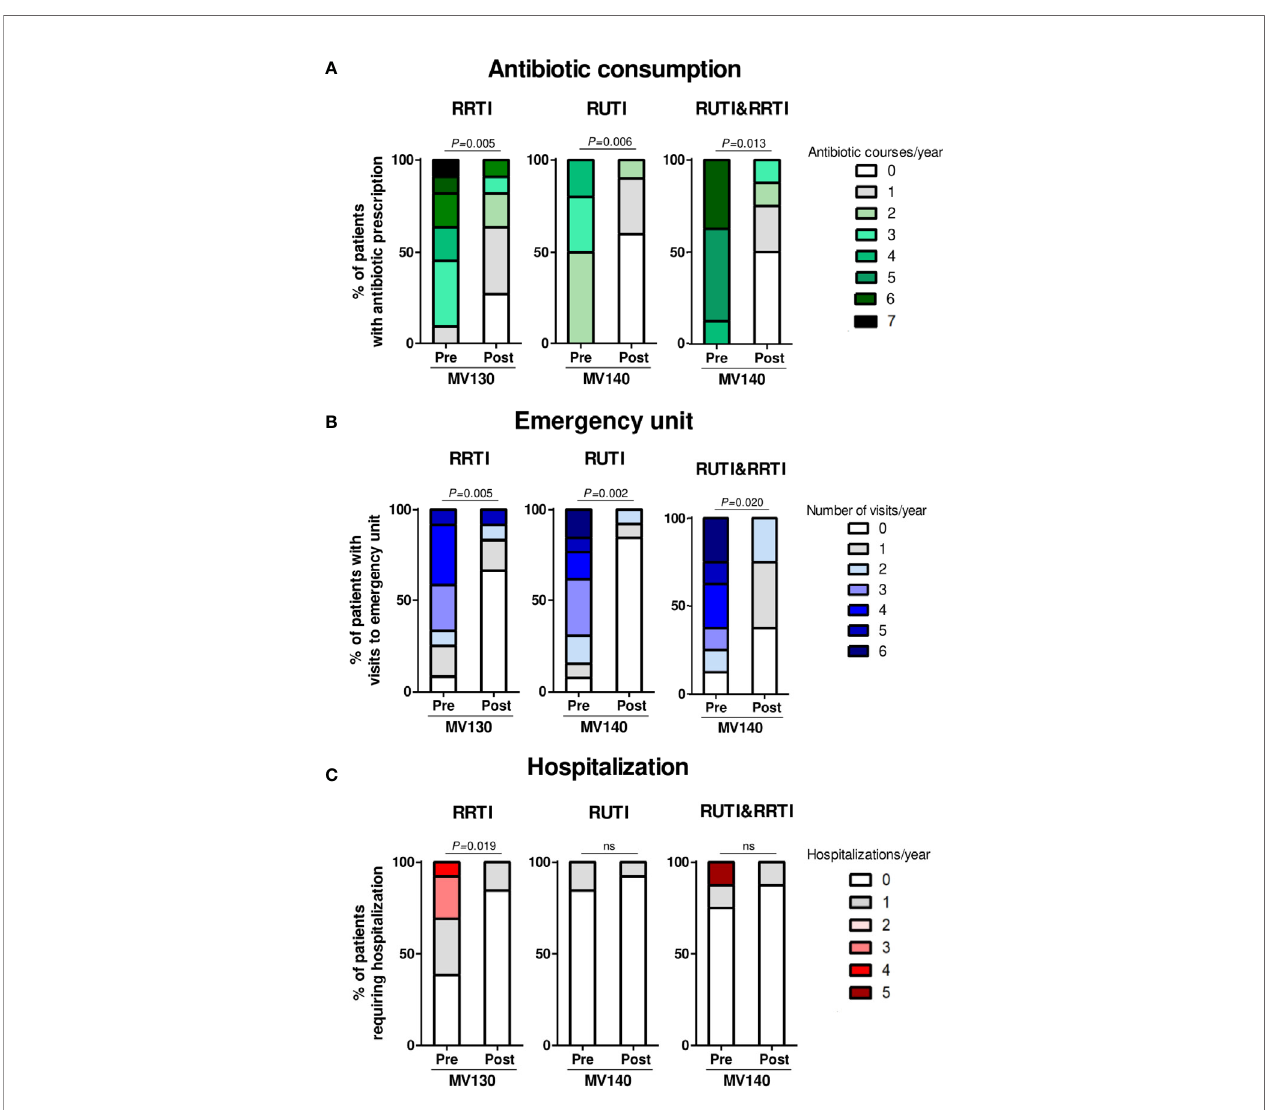
FIGURE 3 | Prophylaxis with MV130 and MV140 reduce the consumption of healthcare resources. (A – C) Antibiotic consumption (A) , unscheduled medical visits (emergency unit and specialist) (B) and hospitalization (C) in subjects suffering RRTI (left panel), RUTI (middle panel) or both (right panel), during the year prior (pre) and after (post) the initiation of the treatment (MV130 or MV140). RRTI: Recurrent respiratory tract infections; RUTI: Recurrent urinary tract infections. Bars show the relative abundance of the number of antibiotic courses (A) , unscheduled medical visits (B) or hospital admissions (C) in the total of subjects recorded. Data from